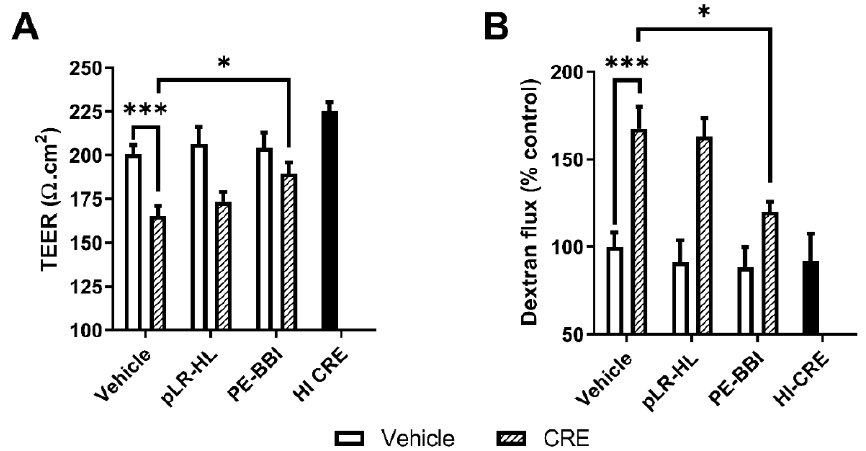
Figure 4. The impact of protease inhibitors on CRE-mediated epithelial barrier disruption. Epithelial barrier function was measured by ( A ) TEER measurement and ( B ) Texas red dextran flux. CRE and heat-inactivated (HI)-CRE were added at the same concentration (16.5 µg protein/well). Data are presented as the mean ± SEMs (n ≥ 4). * P < 0.05, *** P < 0.001.